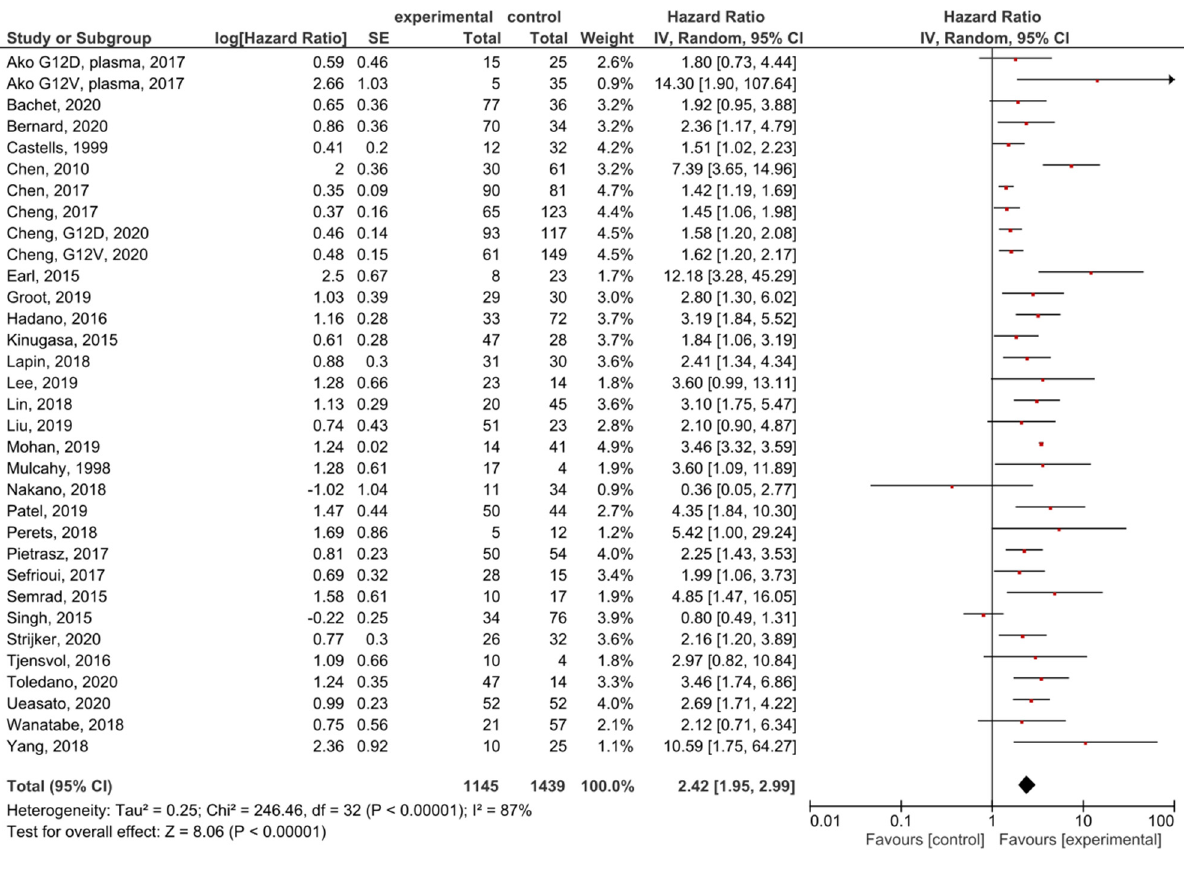
Figure 3. Forest plot presenting the relationship between the presence of KRAS mutations before treatment in PDAC patients and OS.